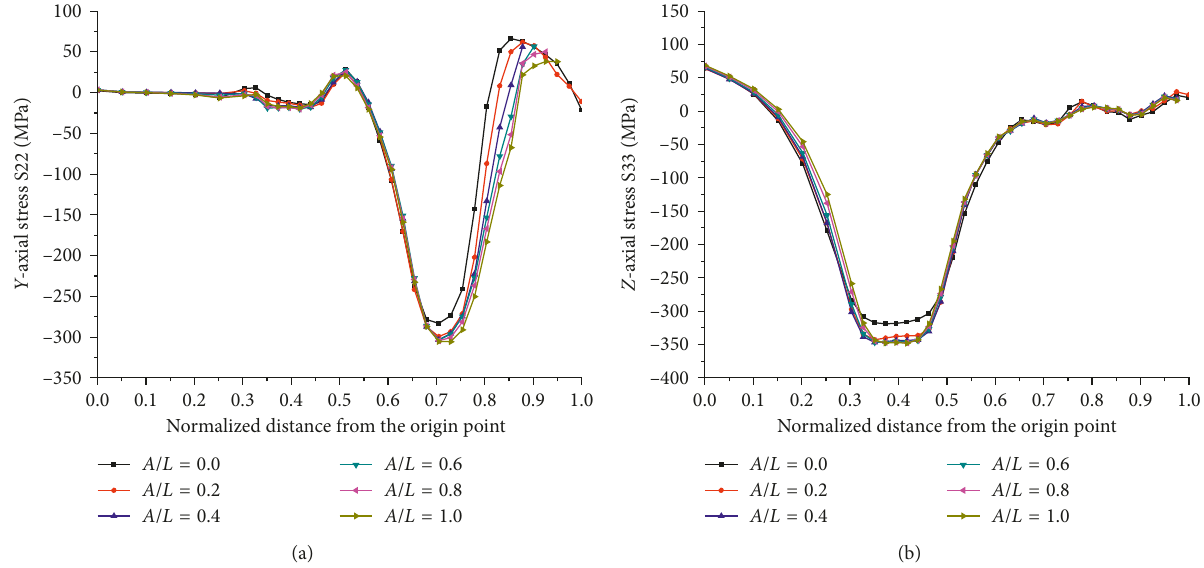
Figure 17: S22 stress and S33 stress distribution curves of the wedge-shaped part of the joint. (a) Y-axial stress distribution curve. (b) Z-axial stress distribution